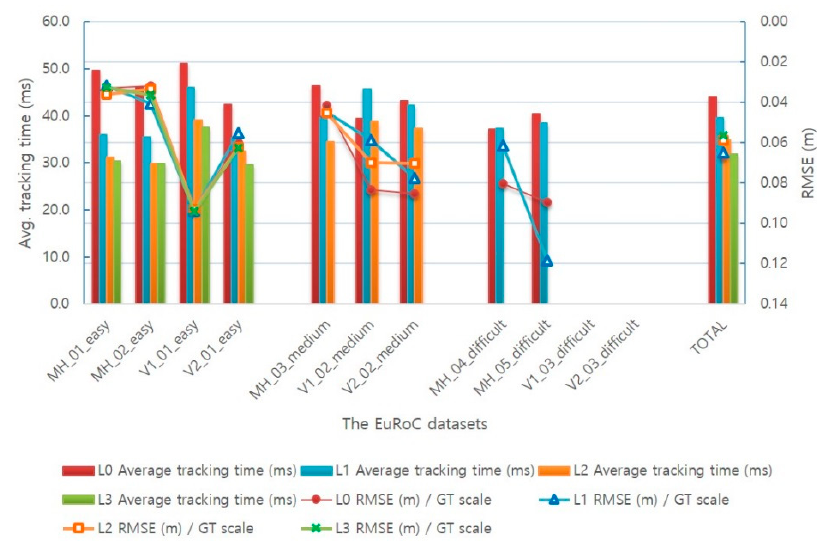
Figure 15. Comparison of the average tracking time and translation RMSE of keyframe trajectory with different level-sets of AVIO-based SLAM in a single-core single-threaded environment.